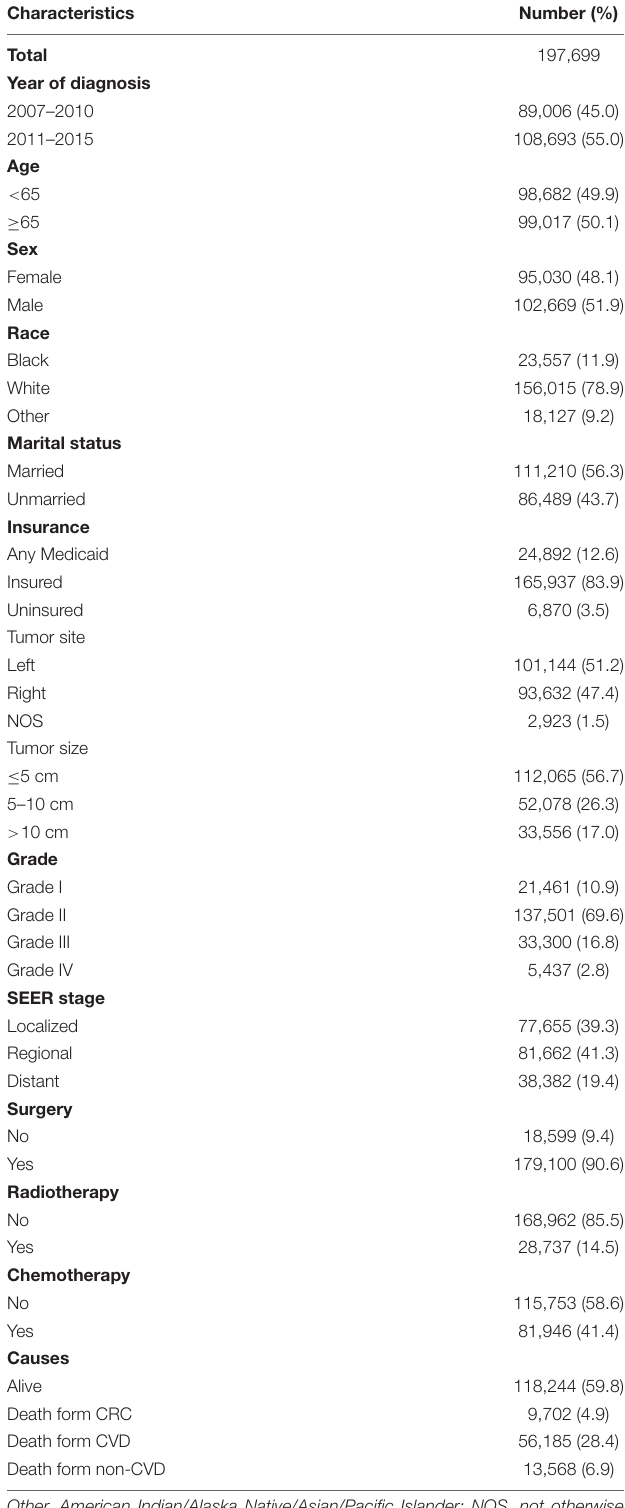
TABLE 1 | Demographic and clinicopathological characteristics of the included CRC patients.